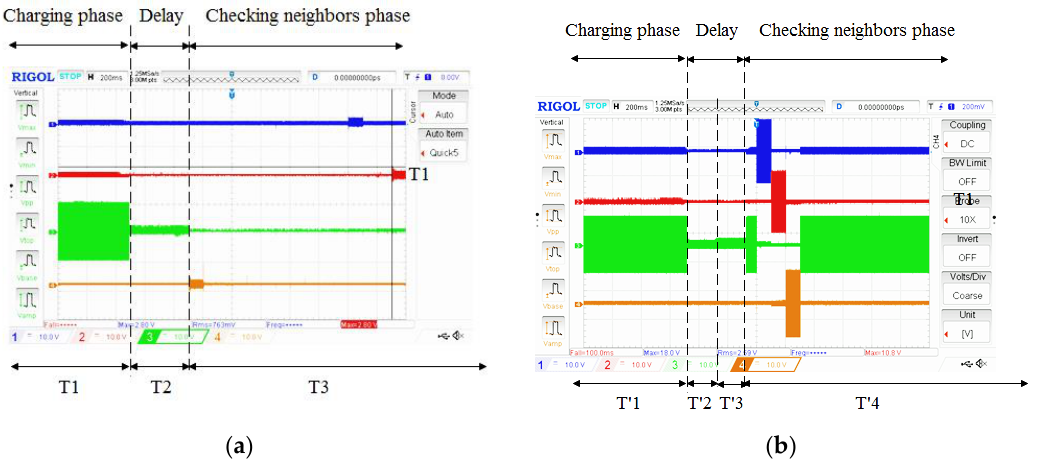
Figure 18. Detection procedure of the receiving coil on the top of C12 ( a ) 3D illustration of the receiving coil position ( b ) Obtained voltages waveform; blue (CH_1) presents the voltage of coil 8, red (CH_2) presents the voltage of coil 9, green (CH_3) presents the voltage of coil 12 and orange (CH_4) presents the voltage of coil 13.